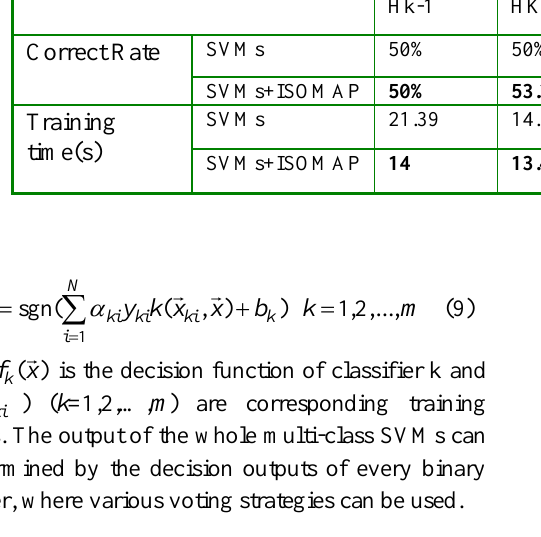
Table 2. Performance comparisons of SVMs with and without ISOMAP-based data selection